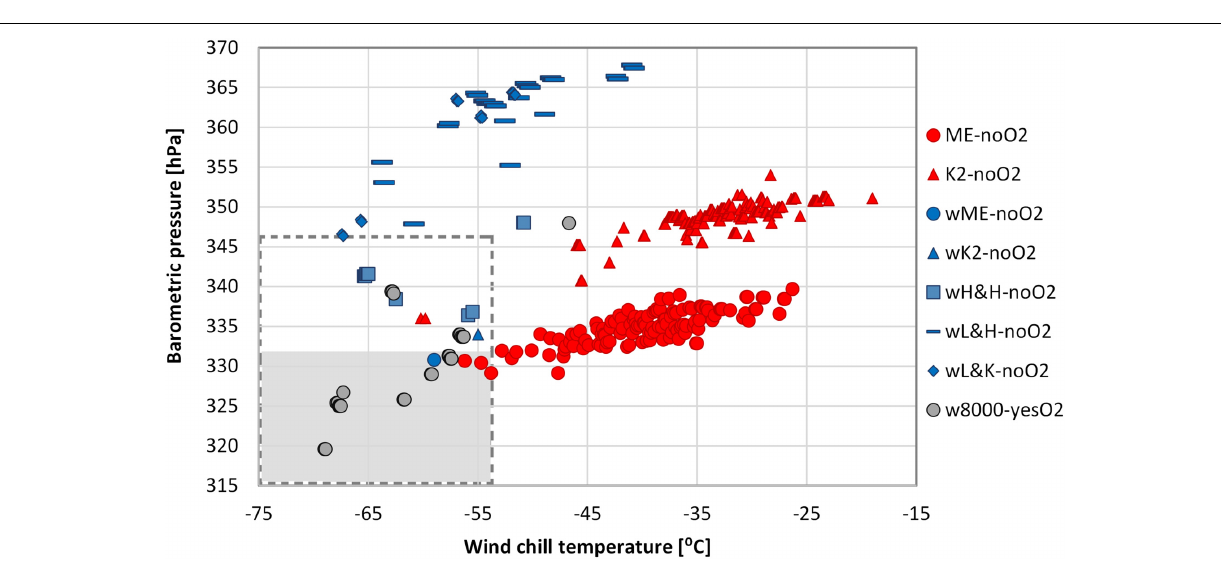
FIGURE 4 | Combined barometric pressure (BP) and wind chill temperature (WCT). Sample size – 499 ascents without supplemental oxygen and 29 with oxygen support (1978–2021). Dashed line box covers ascents in combined conditions of BP ≤ 346 hPa and WCT ≤ − 54 ◦ C, gray area represents ascents in combined conditions of BP ≤ 333 hPa and WCT ≤ − 54 ◦